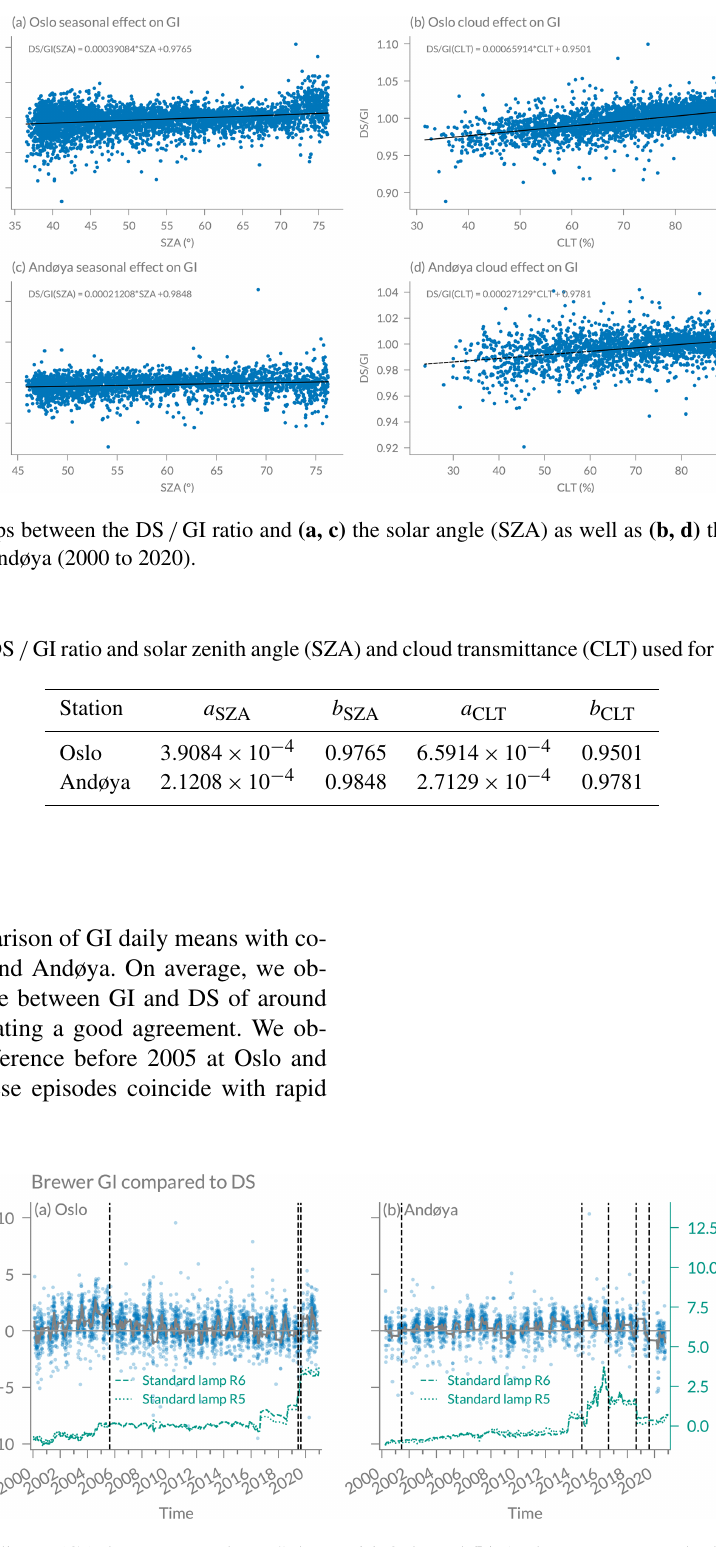
Figure A2. Brewer global irradiance (GI) data compared to DS data at (a) Oslo and (b) Andøya. Data smoothed with a moving mean window of 30d is shown by the thick grey lines. The right axis shows standard lamp (SL) ratios R5 and R6, standardized to zero mean and standard deviation of 1, smoothed with a moving mean window of 30d. Vertical dashed lines show dates that were used for GI